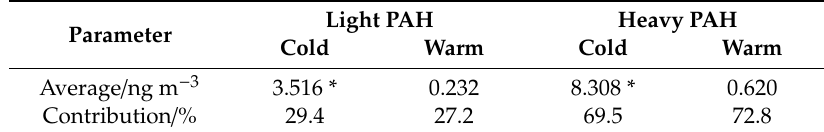
Figure 4. Mass concentrations of light and heavy PAHs measured during one calendar year. Table 2. Contribution of light and heavy PAHs in the sum of measured PAHs during cold period and warm